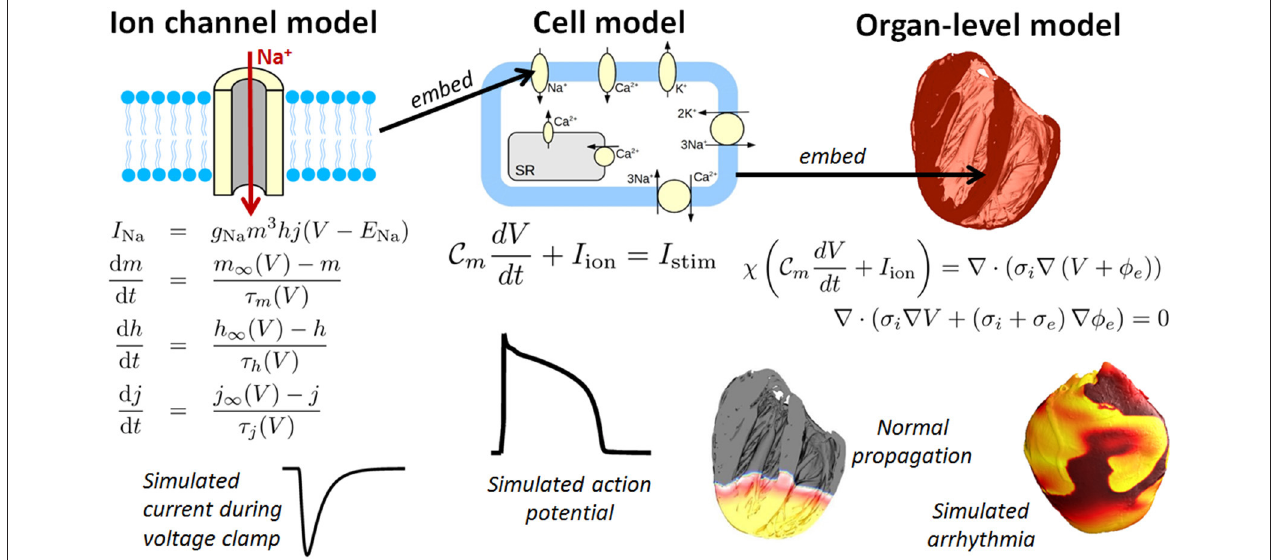
FIGURE 1 | Components of a multiscale cardiac electrophysiology (CEP) model. (Left) : equations and sample output for a Hodgkin-Huxley formulation of the rapid sodium current. Multiple such sub-cellular models can be used to define a cell model. (Center) : schematic of sub-cellular processes included in a hypothetical cell model, together with the differential equation governing the transmembrane voltage, and sample output. Cell models differ in their formulation of the ionic current I ion and can be made up of dozens of ordinary differential equations. (Right) : Cell models can be incorporated into the bidomain equations and solved on a computational mesh of the heart [top right: high-resolution rabbit biventricular mesh of Bishop et al. (2010)], to simulate normal or arrhythmic cardiac activity (bottom